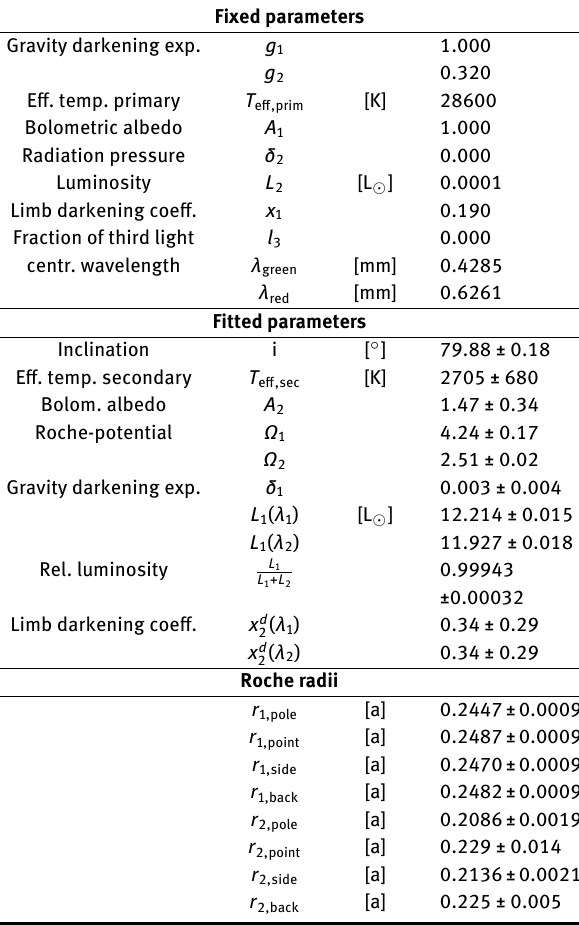
Table 4. Best-fit model parameters of the light curve for q =